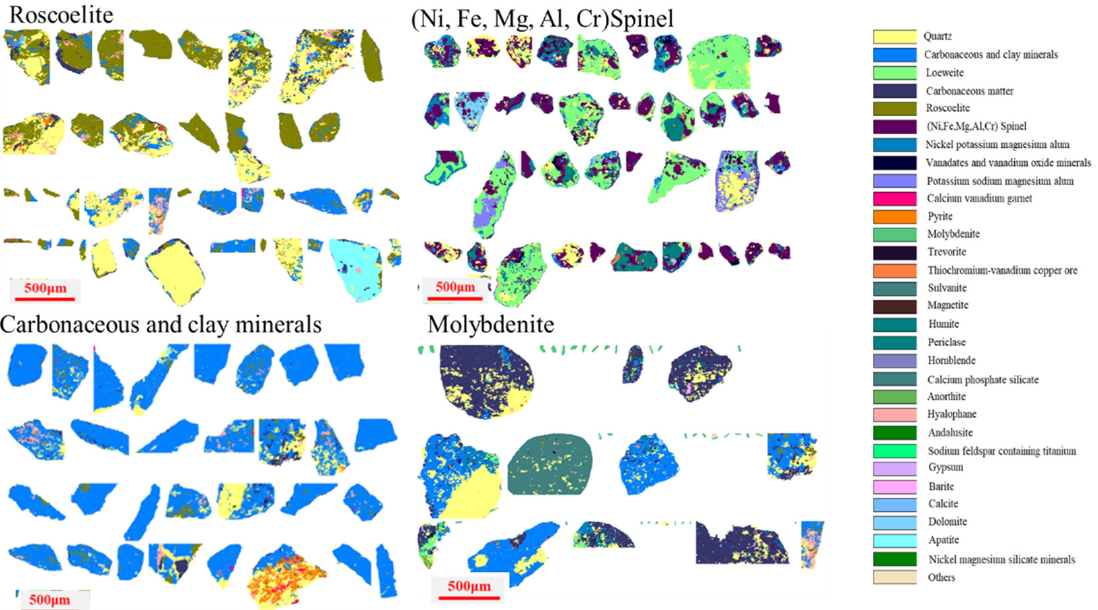
Figure 4. Embedded characteristics of key minerals.